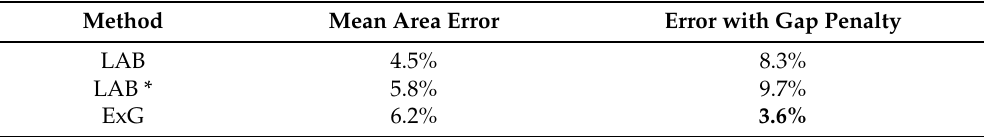
Table 4. Mean area error and error with gap penalty of testing set. Bold is the best result compared with other methods. * indicates that the model training time is